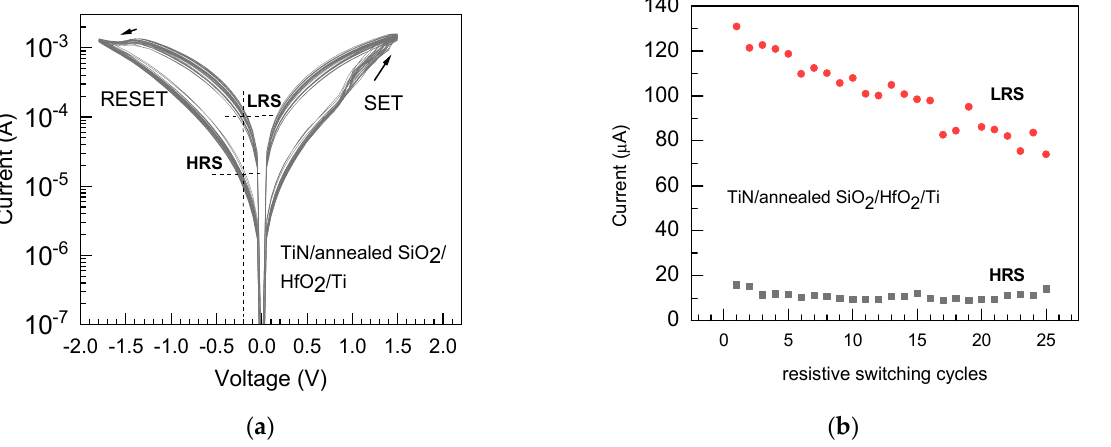
trode was 250 µm. LRS and HRS denote the low- and high-resistance states, respectively.